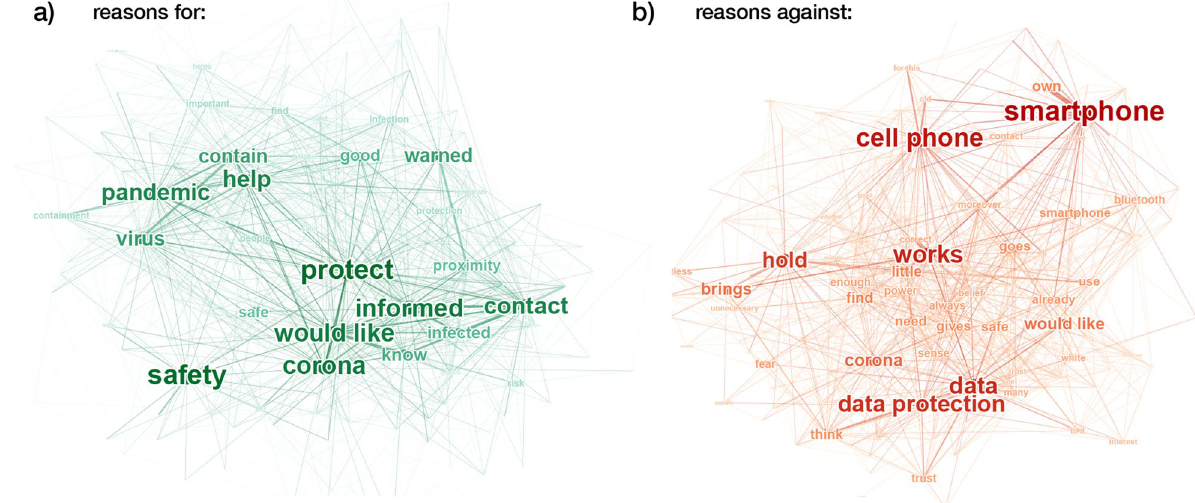
Figure 9. Self-reported reasons to download or not download the Corona-Warn-App in an open-response question (Wave 4 only; reasons for: N = 477; reasons against: N = 530). Co-occurrence networks of unigrams from reasons for ( a ) and against ( b ) downloading the app. Connections appear whenever two words were used by the same participant. Node and font sizes and color code are proportional to the absolute frequency of the corresponding word; nodes are positioned using a spring layout. Only unigrams that appeared at least three times in the responses are shown. Translation on a unigram basis via DeepL.com; visualization via Gephi 29